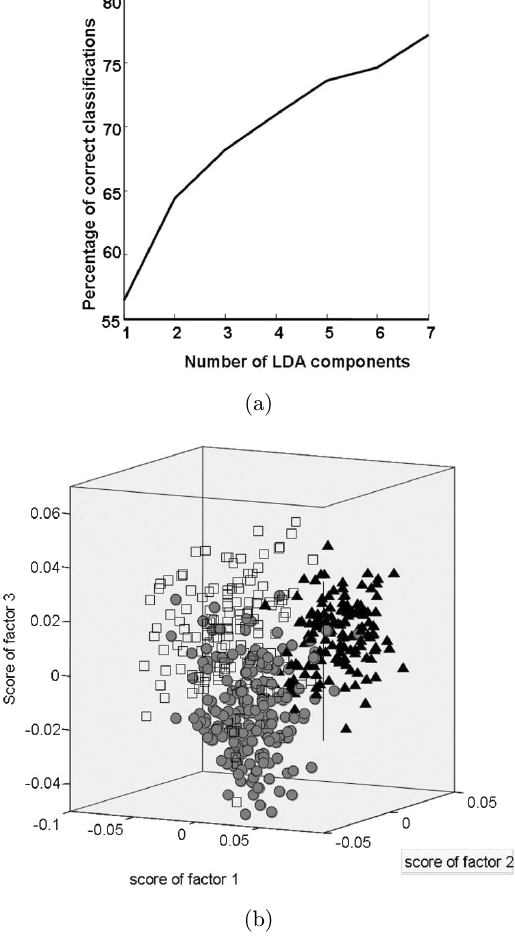
Fig. 3. PC-LDA of normal, tumor and CR tissues: (a) Scree plot, (b) 3D scatter plot of normal ( N ), tumor ( . ) and CR spectra (